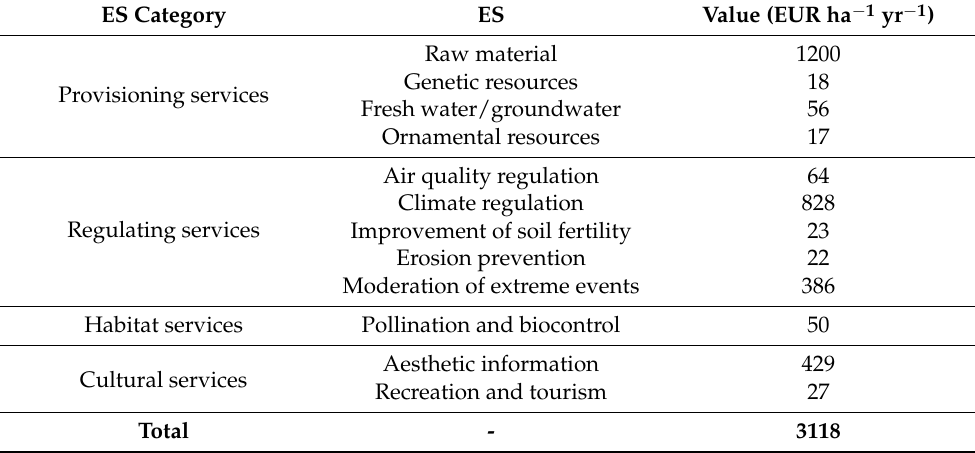
Table 4. Single monetary values and total value of the ESs in EUR ha − 1 yr − 1 provided by miscanthus cultivation adapted from Winkler et al. (2020) [19] and von Cossel et al. (2020b) [9]. For those ESs in which ranges of variation are given in von Cossel et al. (2020b) [9], the arithmetic means were calculated. Some ESs (e.g., nutrient cycling, N 2 fixation) shown in von Cossel et al. (2020b) [9] were excluded in this study, as explained in Section 2.3.